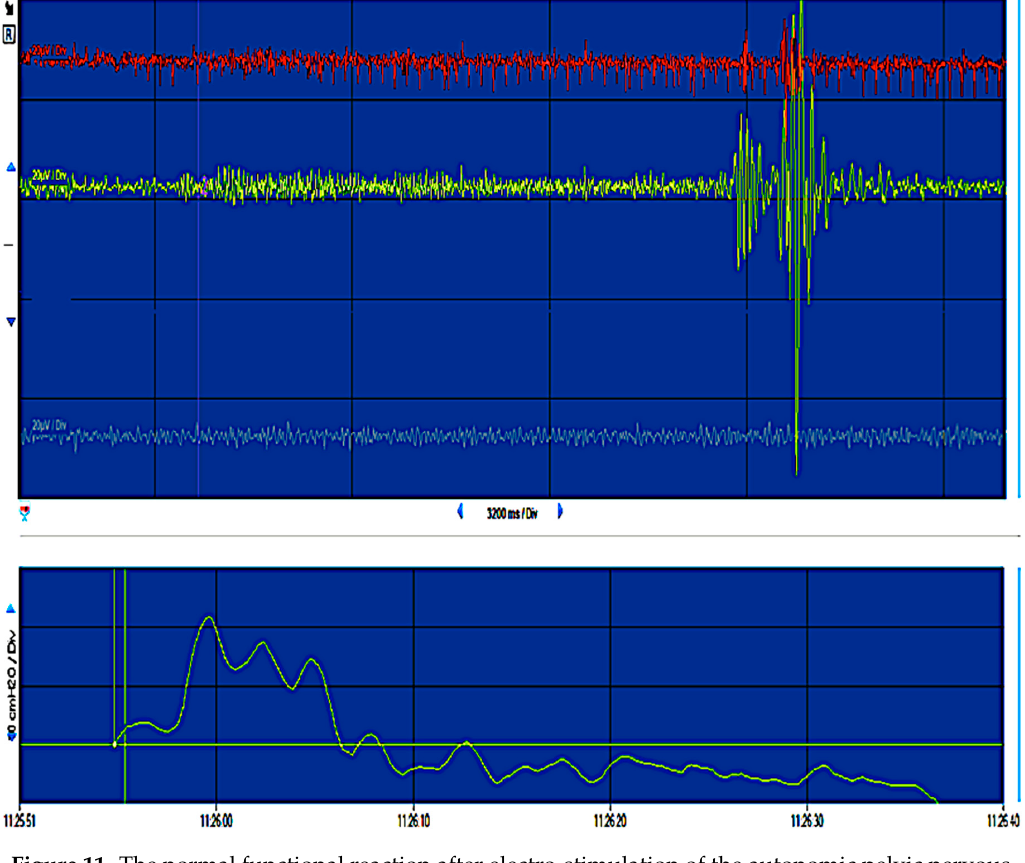
Figure 11. The normal functional reaction after electro-stimulation of the autonomic pelvic nervous system during intra-operative pelvic neuromonitoring after nerve-sparing radical hysterectomy (an example of neuromonitoring report from this study).